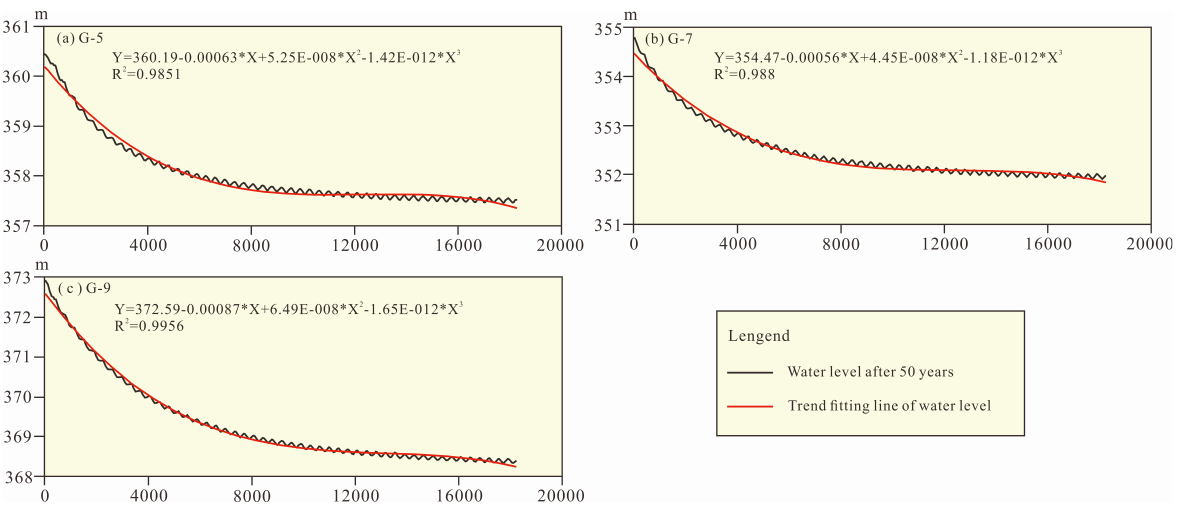
Figure 11. Maps that show the ( a ) decrease in water level and ( b ) buried depth after 50 years for scenario 3.